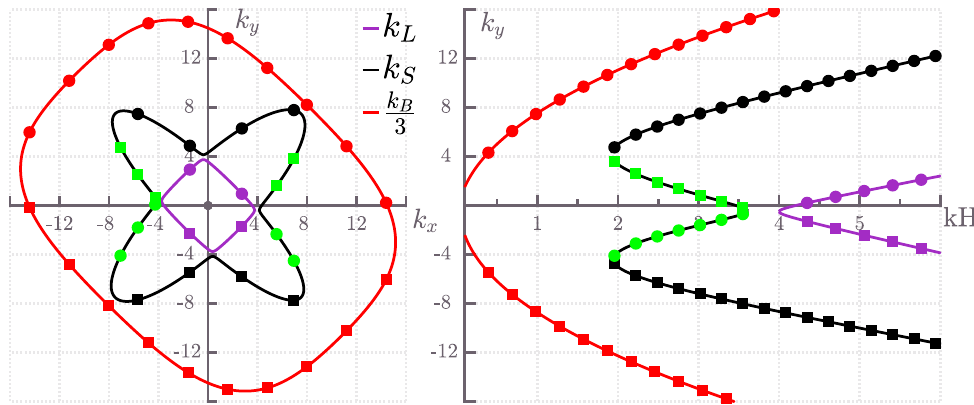
Figure 8. Wave vector (left) and dispersion (right) curves for an angle-ply composite plate. Longitudinal ( k L ), shear ( k S ) and bending ( k B ) curves are depicted in purple, black and red colour, respectively. Squares and circles denote wave numbers of incoming and outgoing waves, respectively. Furthermore, green squares and circles represent parts of the shear wave vector and dispersion curves that exhibit negative group velocity behaviour. The wave vector curves are plotted for a fixed frequency f = 3000 Hz, whereas the dispersion curves are plotted for a fixed wave number component k x = 5 m − 1